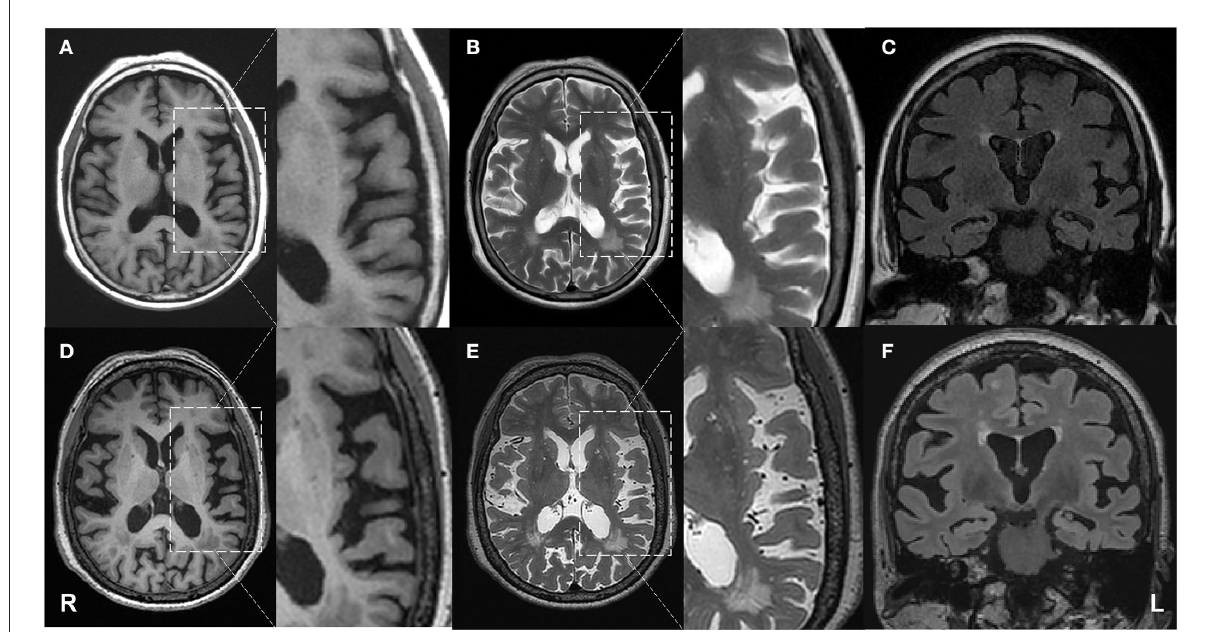
FIGURE1 Progressive brain atrophy was detected by structural MRI. First row: MRI on 15 February 2019; second row: MRI on 25 April 2021. (A,D) axial T1 weighted images; (B,E) axial T2 weighted images; (C,F) coronal FLAIR images. The patient showed atrophy in the left temporal lobe compared with the